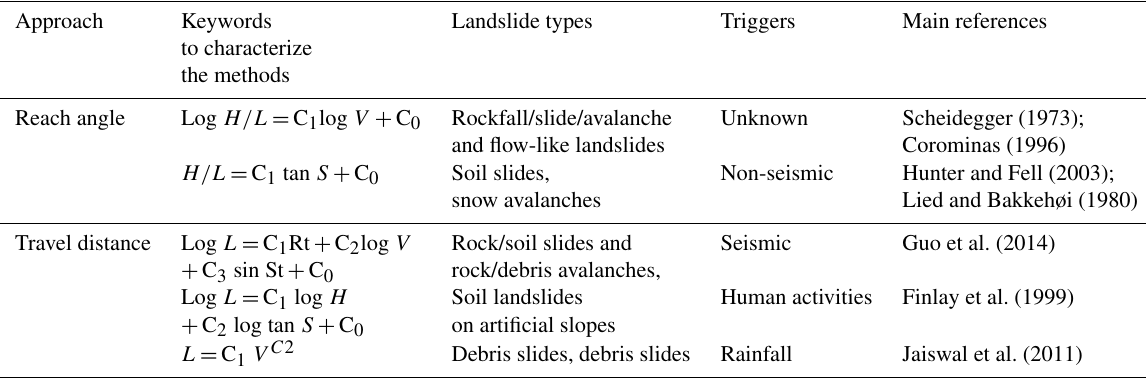
Table 1. Summarization of statistical relationships indicating landslide mobility in the literature.